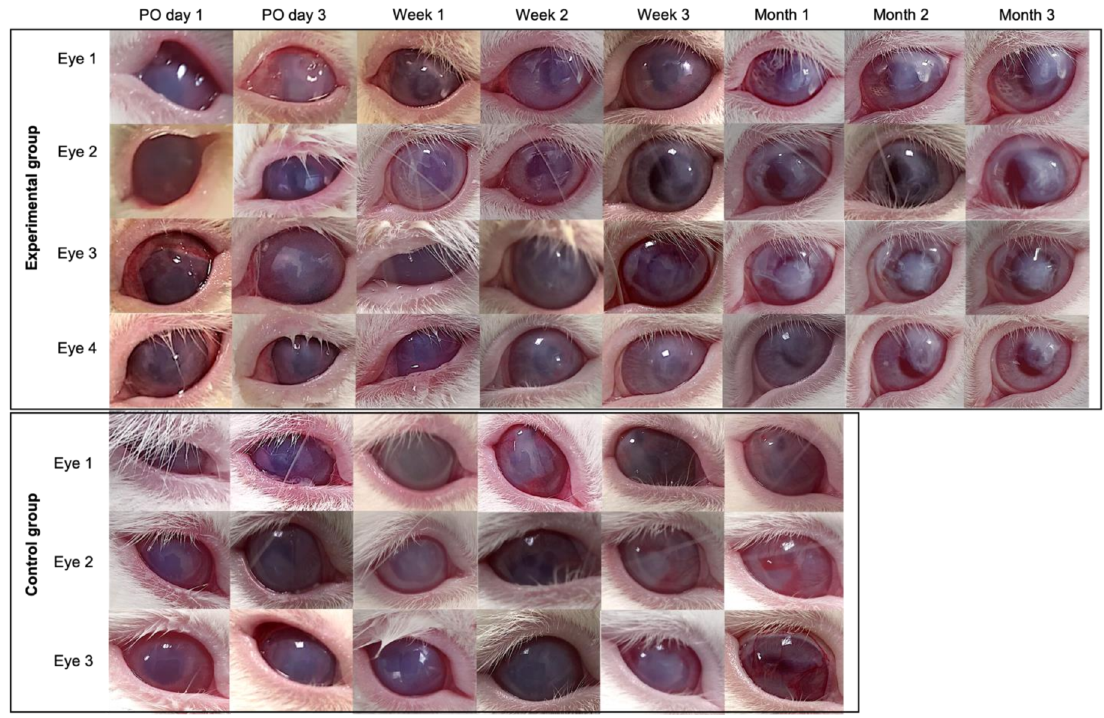
Figure 8. Postoperative follow up of eyes transplanted with CECs/CVM construct and with 2X CVM alone. The eyes with CECs/CVM transplant recovered peripheral transparency, while eyes transplanted with 2X CVM consistently showed edema.